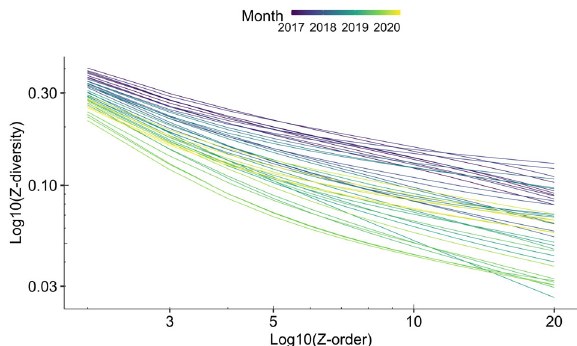
Fig. 7 Monthly evolution of Zeta diversity. The x -axis represents the order of Zeta and the y -axis the z -value, or mean percentage of songs shared across groups of x countries. Both axes are represented on a log10 scale.